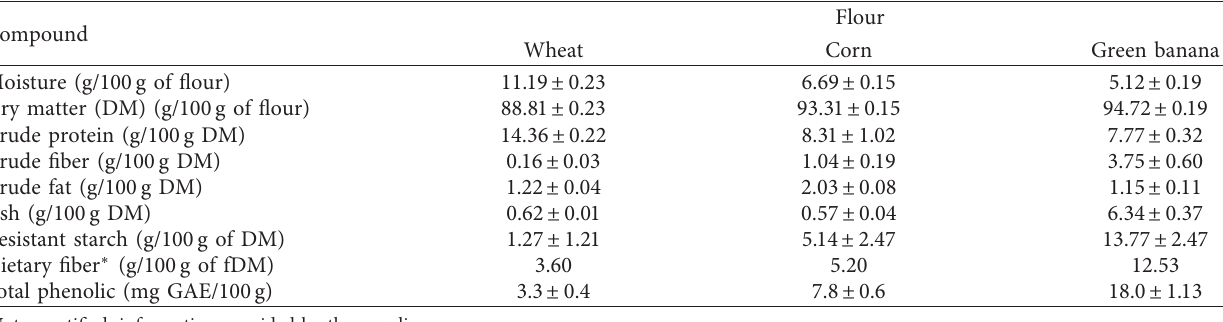
Table 4: Proximate chemical composition and total phenolic content of the different flours used to produce breads with partial wheat flour replacement.